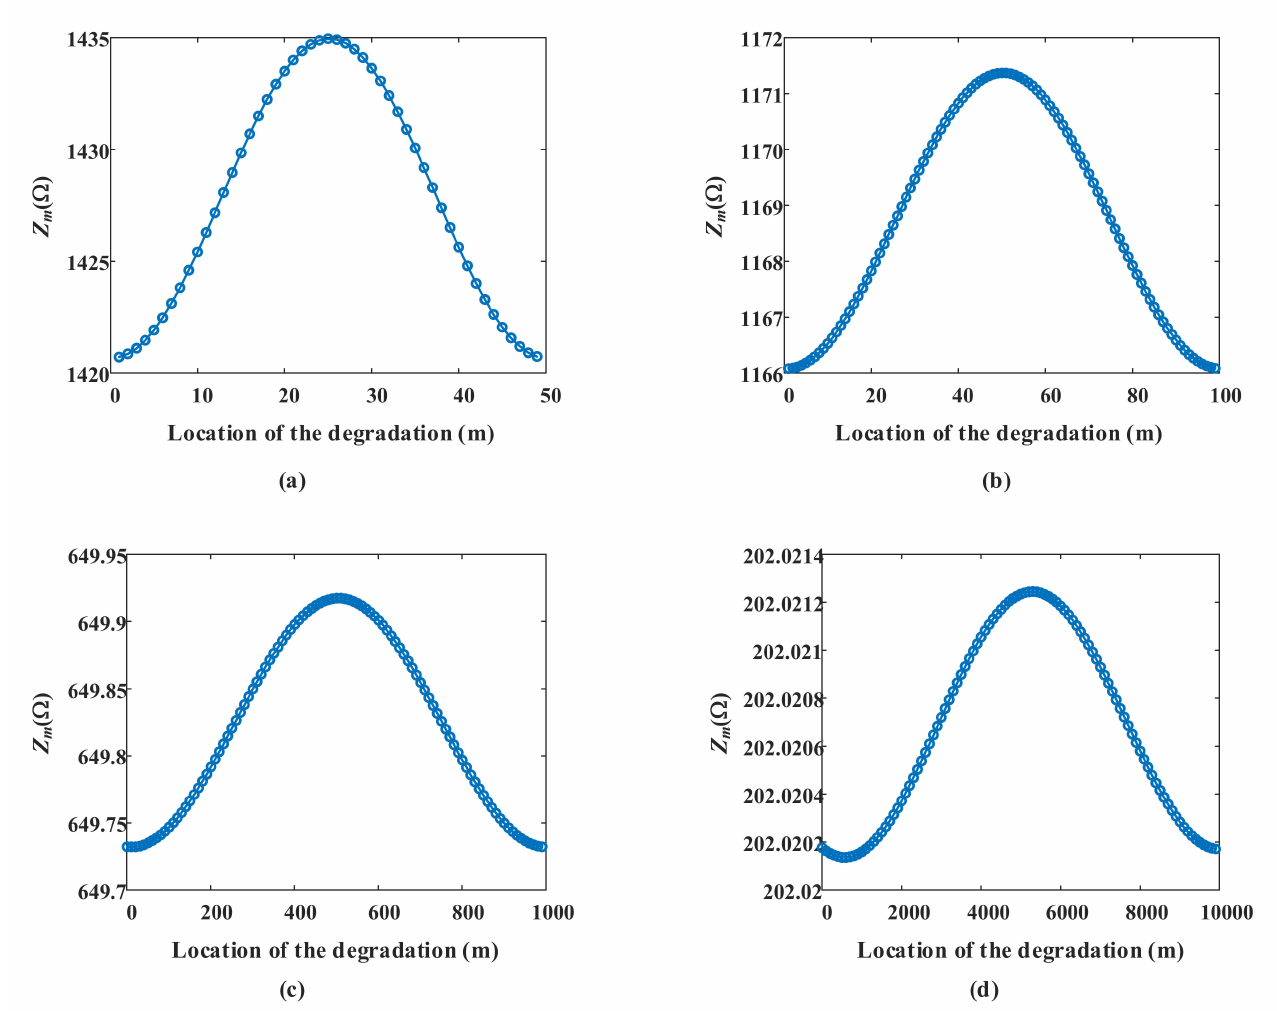
Figure 7. The relationship between the impedance magnitude at the characteristic frequency and the position of the degradation for ( a ) 50 m, ( b ) 100 m, ( c ) 1000 m, ( d ) 10,000 m